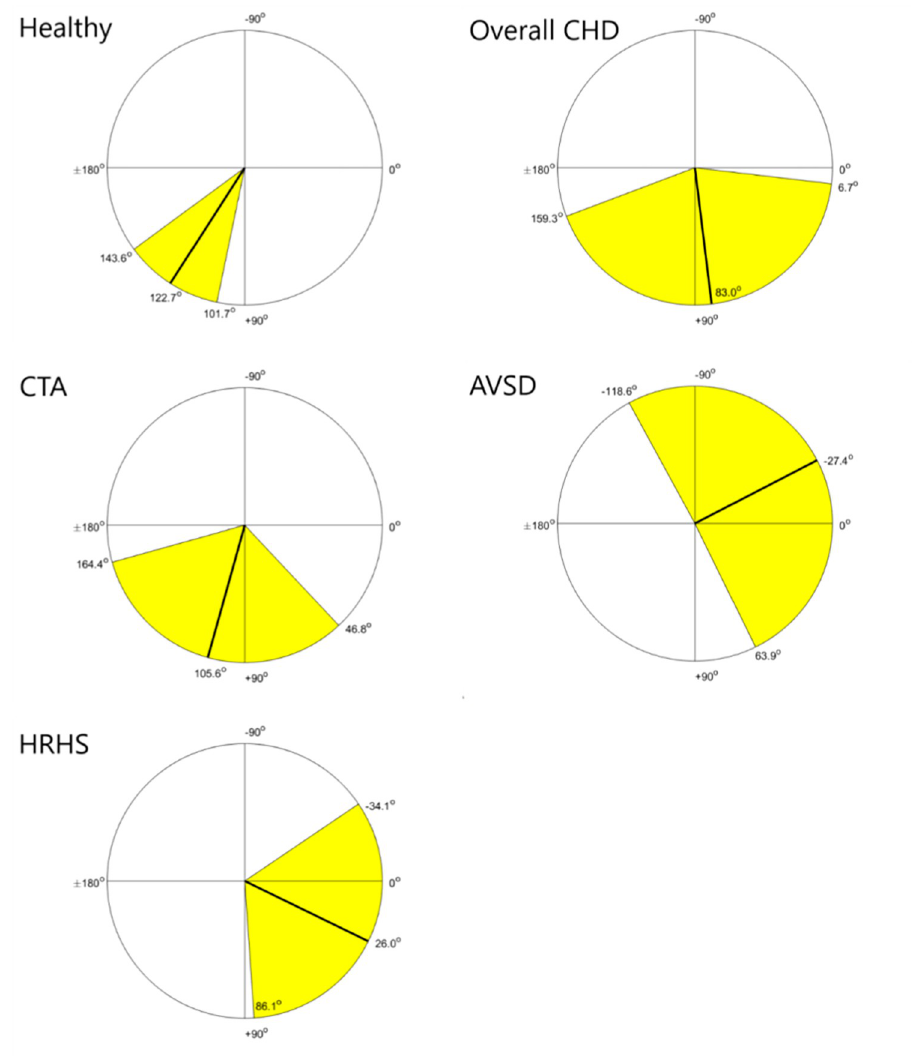
Fig 3. Mean electrical heart axis (MEHA) with corresponding 95% CI in the frontal plane plotted in a circle diagram for each group. Abbreviations: AVSD = atrioventricular septal defect, CHD = congenital heart disease, CTA = conotruncal anomalies, HRHS = hypoplastic right heart syndrome.